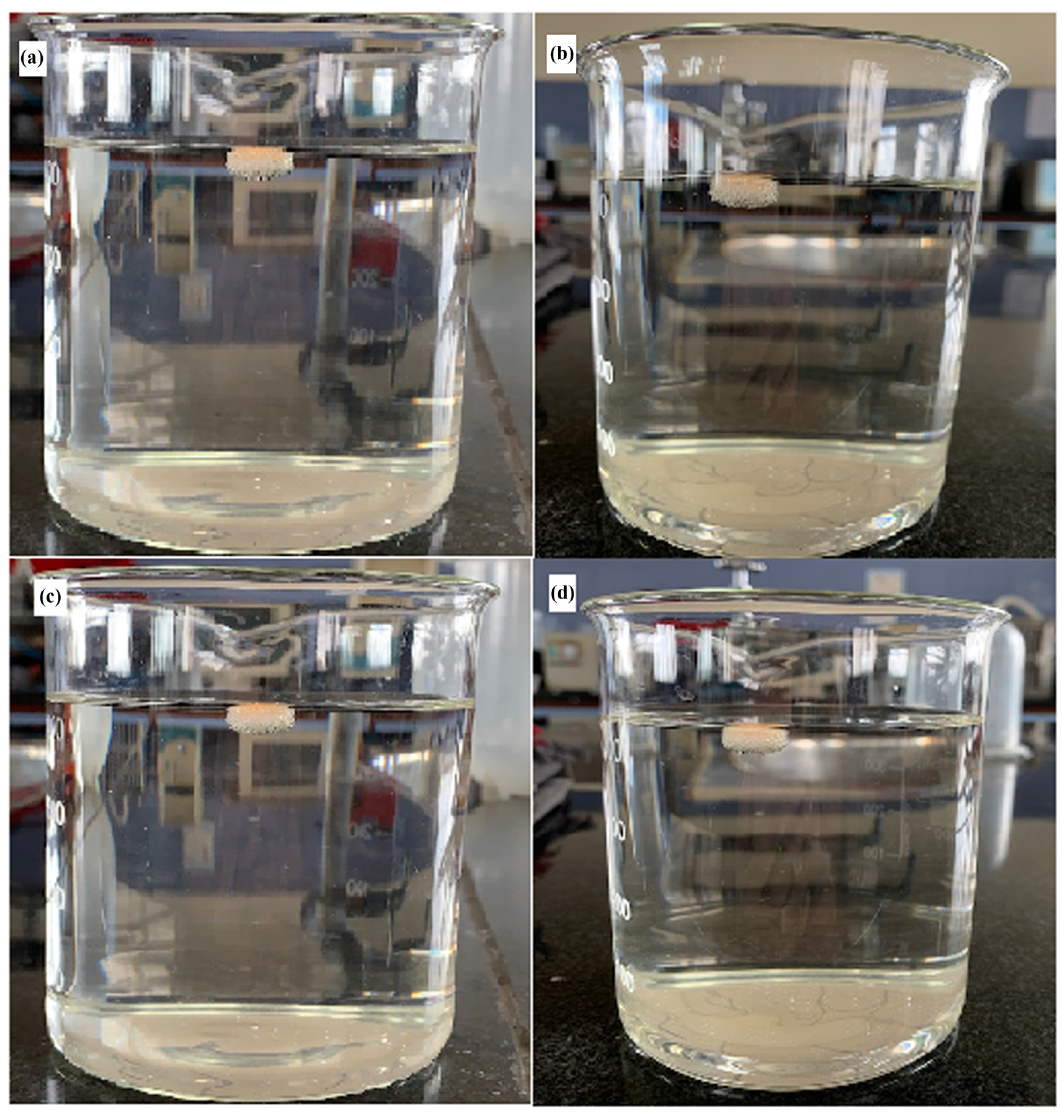
Figure 2: Photographs depicting the side view of bilayer tablets of CC in pH 1.2 bu ff er at 1 h ( a ) , 2 h ( b ) , 4 h ( c ) , and 6 h ( d )